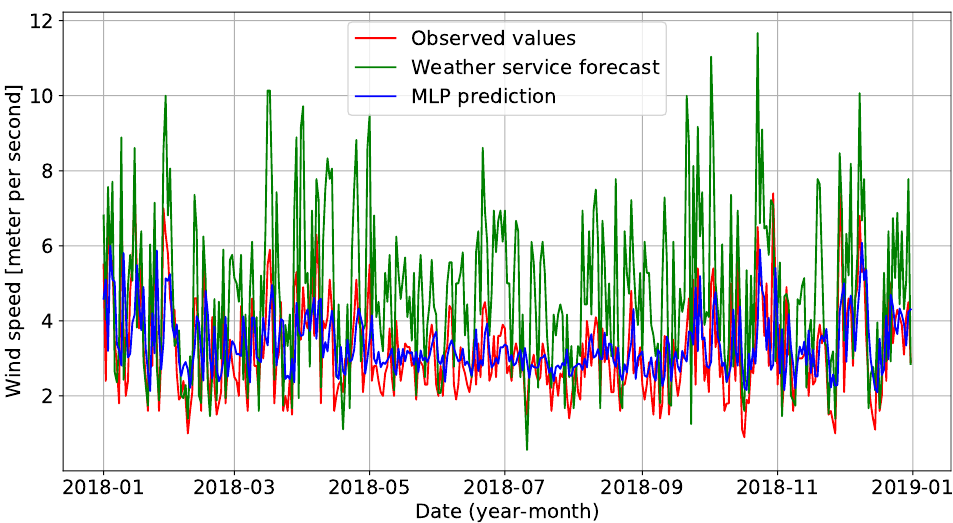
Figure 6. Comparison between the observed values and those predicted by the MLP and the weather service mean wind